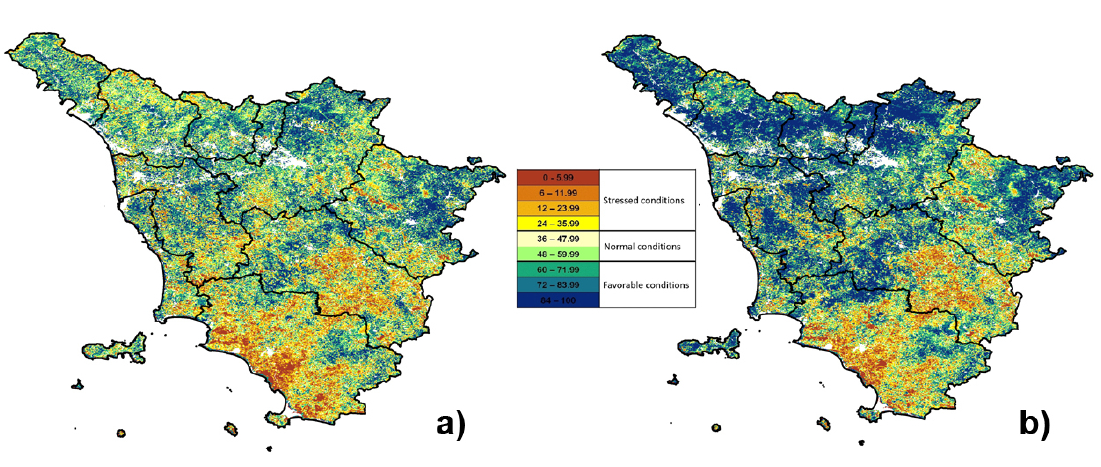
Figure 4. ( a ) E-VCI (Enhanced-Vegetation Condition Index) related to the 16–31 October 2017 period; ( b ) VCI (Vegetation Condition Index) related to the 16–31 October 2017 period.